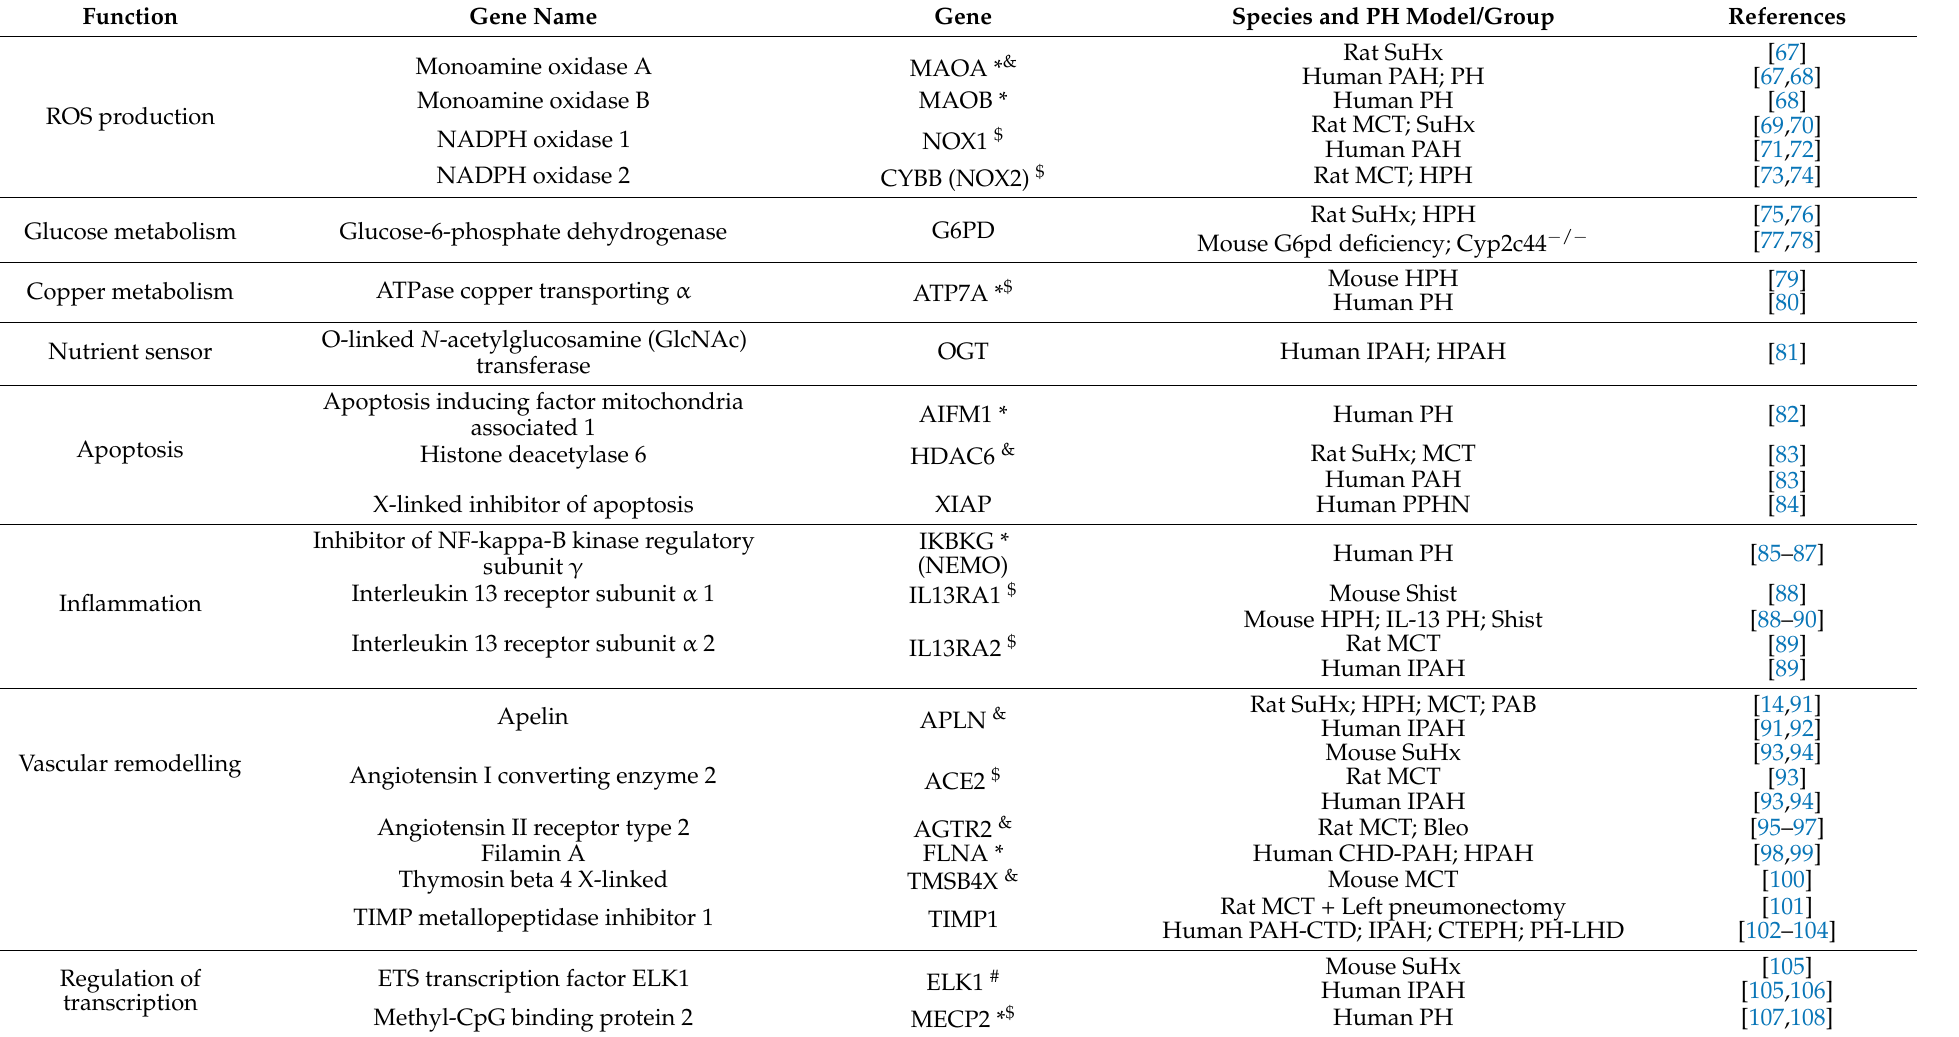
Table 1. X chromosome genes implicated in pulmonary